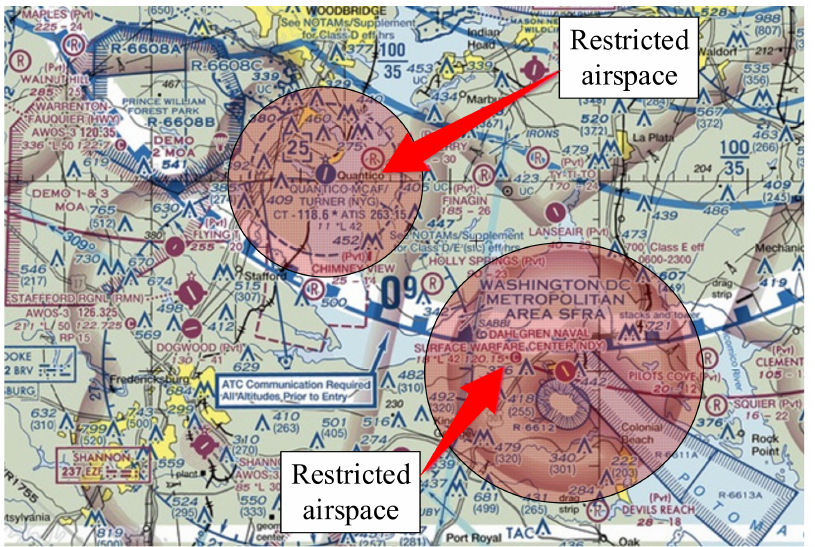
Figure 2. Example of restricted airspace (clearance map of Pendleton Oregon, Kunming, United States of America).